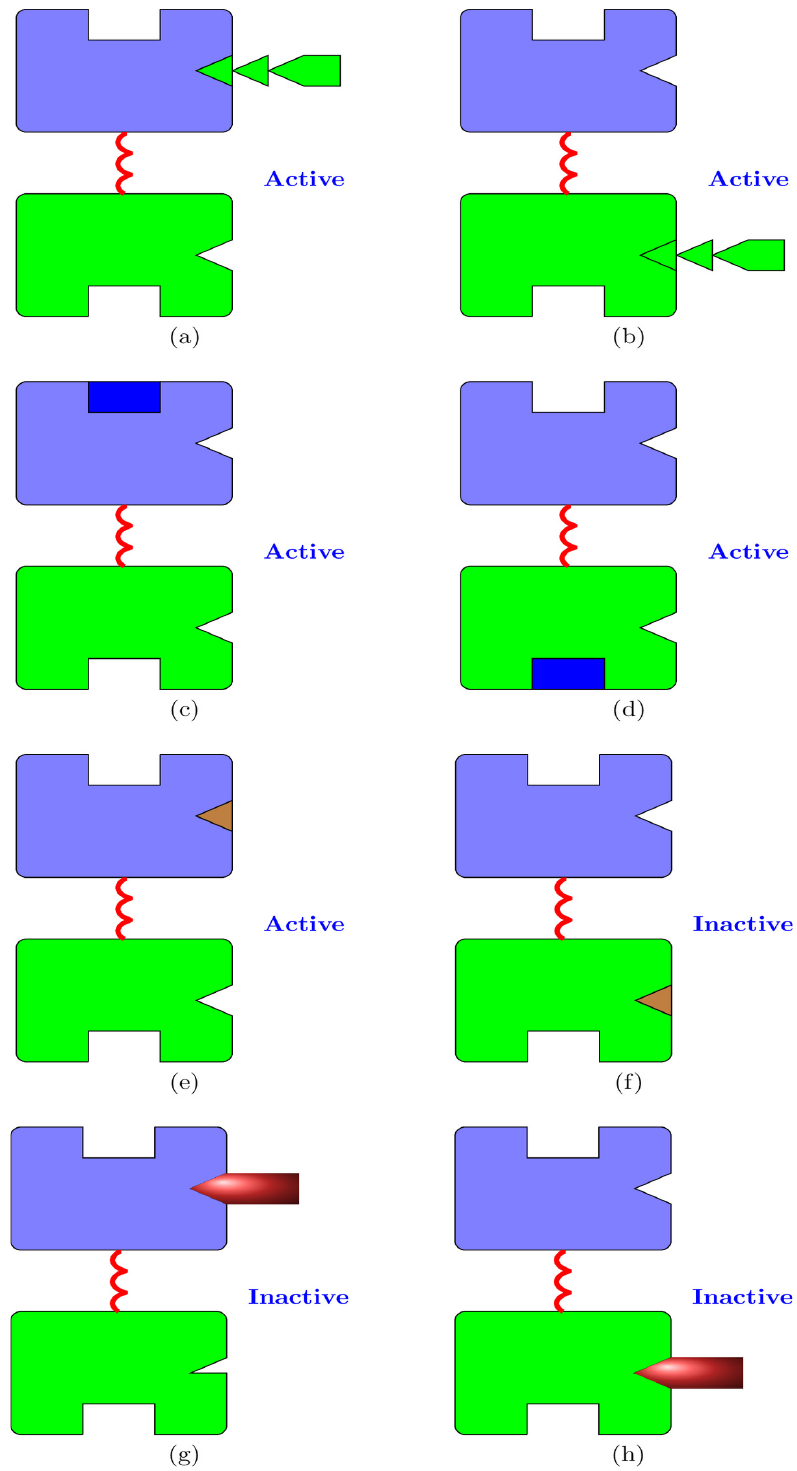
Figure 3. The eight possible configurations of a hexokinase molecule where only one of the binding sites is occupied. Figures ( a – e ) depict active states for the enzyme, while ( f – h ) depict inactive states. ( a ) An ATP molecule bound to the N -domain. ( b ) An ATP molecule bound to the C -domain. ( c ) A glucose molecule bound to the N -domain. ( d ) A glucose molecule bound to the C -domain. ( e ) A P i molecule bound to the N -domain. ( f ) A P i molecule bound to the C -domain (competitive inhibition). ( g ) A G 6 P molecule bound to the N -domain (allosteric product inhibition). ( h ) A G 6 P molecule bound to the C -domain (competitive product